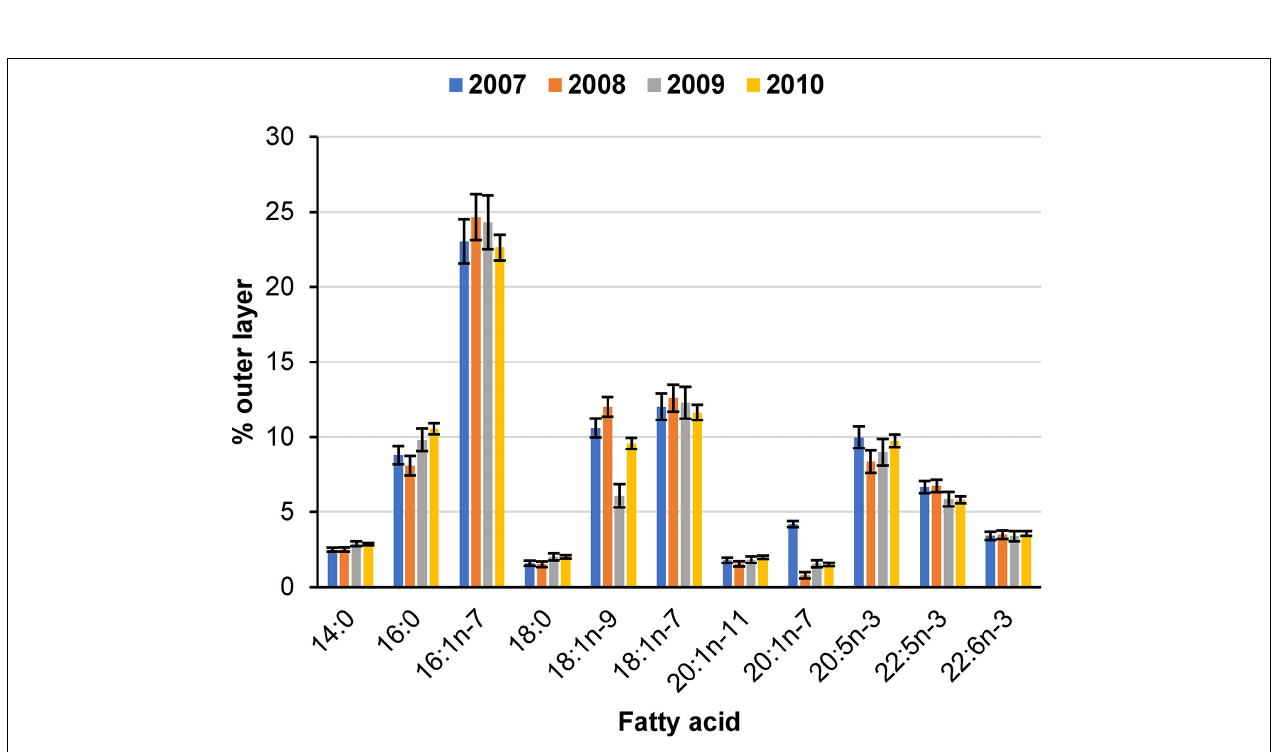
FIGURE 6 | Estimated mean ( ± 2SE) composition in percent abundance of major fatty acids of the outer blubber layer from the sternum of 17, 16, 15, and 52 lactating Pacific walruses in spring 2007–2010, respectively.